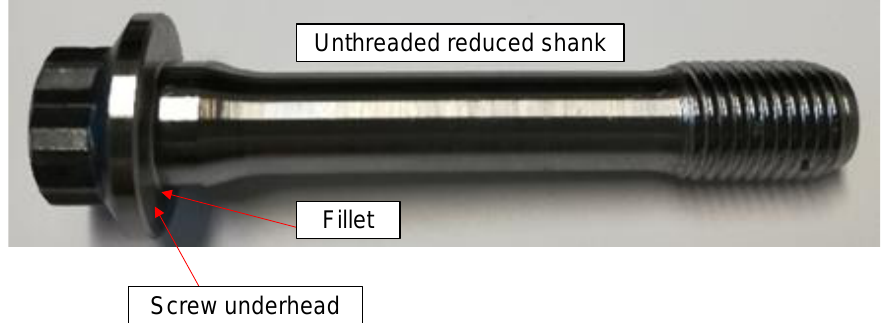
Figure 1. Geometry of the screws involved in the experimental campaign for tribological properties.